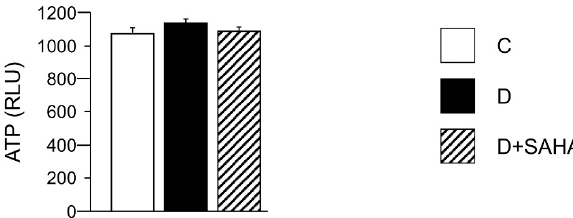
Figure 3. E ff ect of SAHA treatment on cardiomyocyte ATP content. Mean values ± SEM of ATP content in control (C), diabetic (D), and SAHA-treated D cells (D + SAHA). Values are expressed as relative light units (RLU) counts / s. Kruskal–Wallis and U Mann–Whitney test.